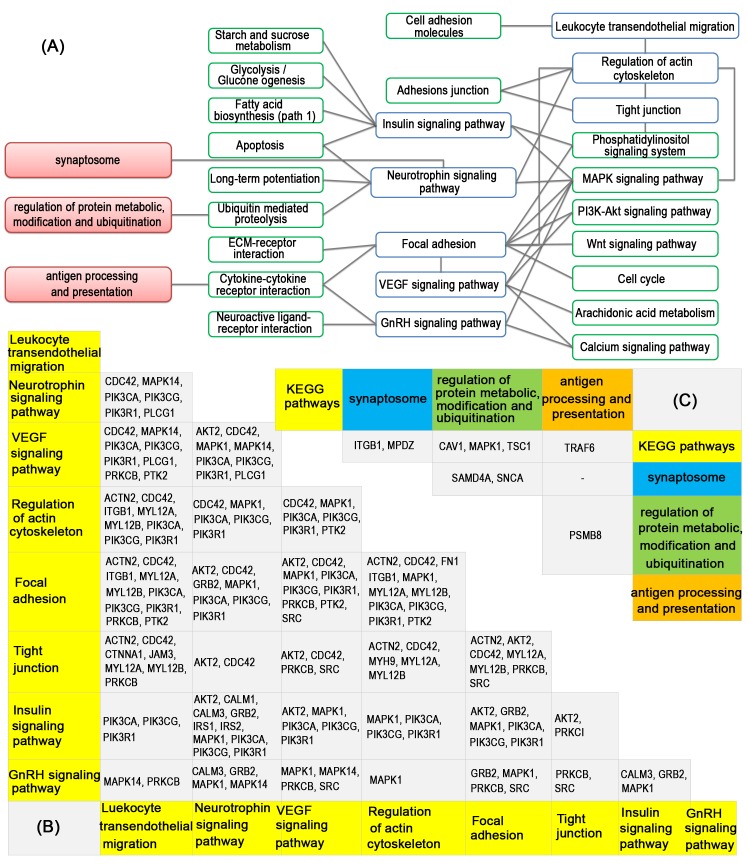
Crosstalk analysis of enriched pathways/GO terms.Panel A shows the connections among the enriched pathways/GO terms. Blue squares are enriched KEGG pathways, green squares are their connected pathways from KEGG, red squares are enriched GO terms. Panel B shows the shared genes between the first group of enriched pathways. Panel C shows the shared genes between four groups of enriched pathways/GO terms. The genes in groups with more than one pathway/GO term were combined for the shared gene analysis.